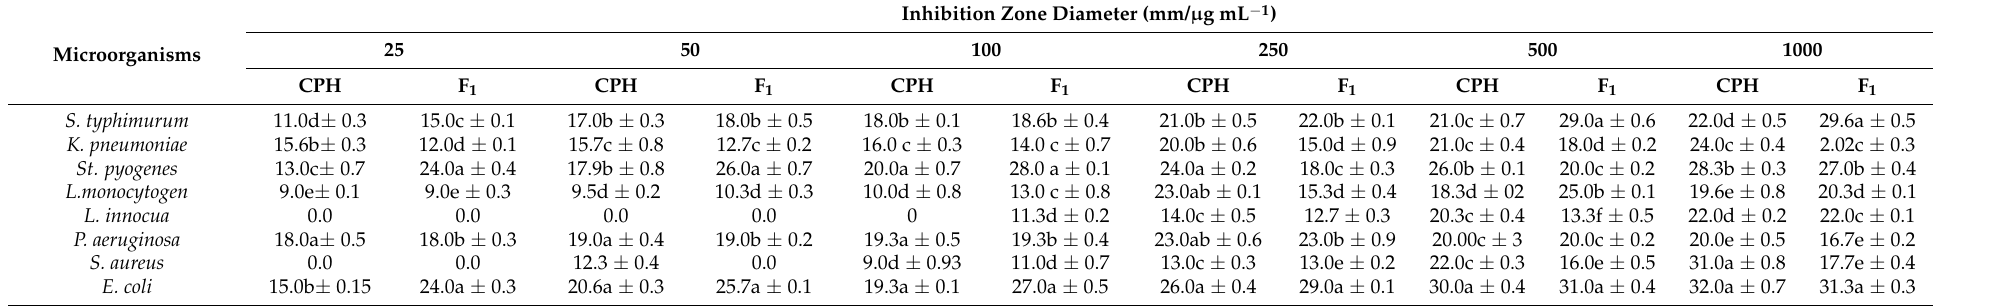
Mean in the same row having different letters are significantly different ( p ≤